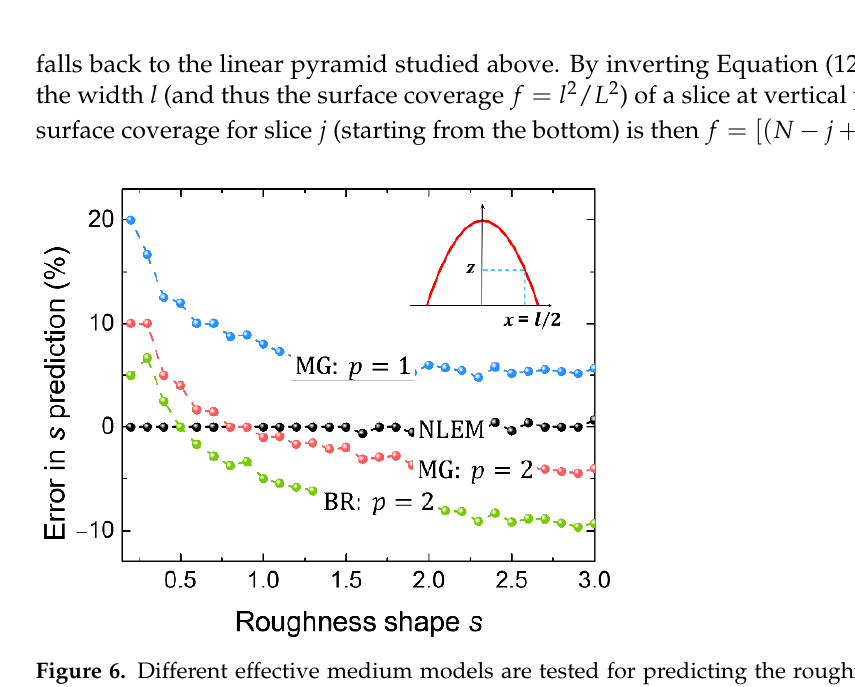
Figure 6. Different effective medium models are tested for predicting the roughness shape s , by fitting to corresponding FDTD results (for H = 32 nm). The NLEM model is the only one offering error-free prediction for all roughness shape values.